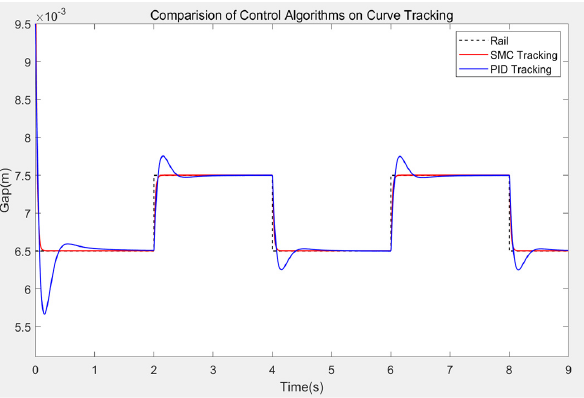
Figure 8. Comparison of curve tracking under SMC and PID algorithms.